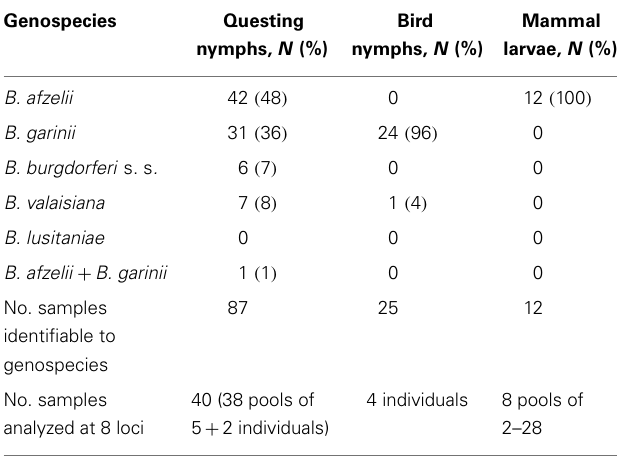
Table 1 | Genospecies grouping of Scottish isolates by sample type and the number and type of samples processed using MLST at eight loci